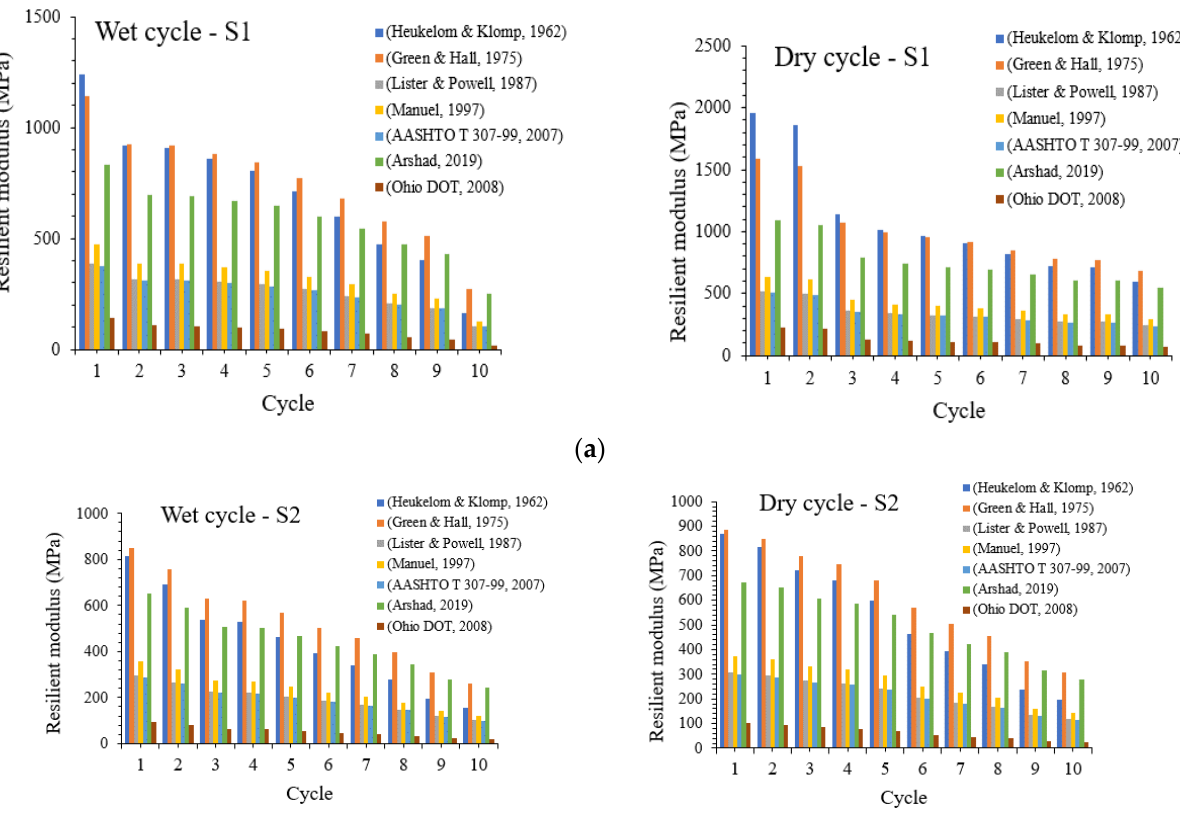
Figure 7. ( a ) Resilient modulus results for subgrade 1 composed of GGBS and BDW after 28 days of curing. ( b ) Wetting – drying cycle results for subgrade 2 composed of GGBS and BDW after 28 days of curing [55,59 – 64].